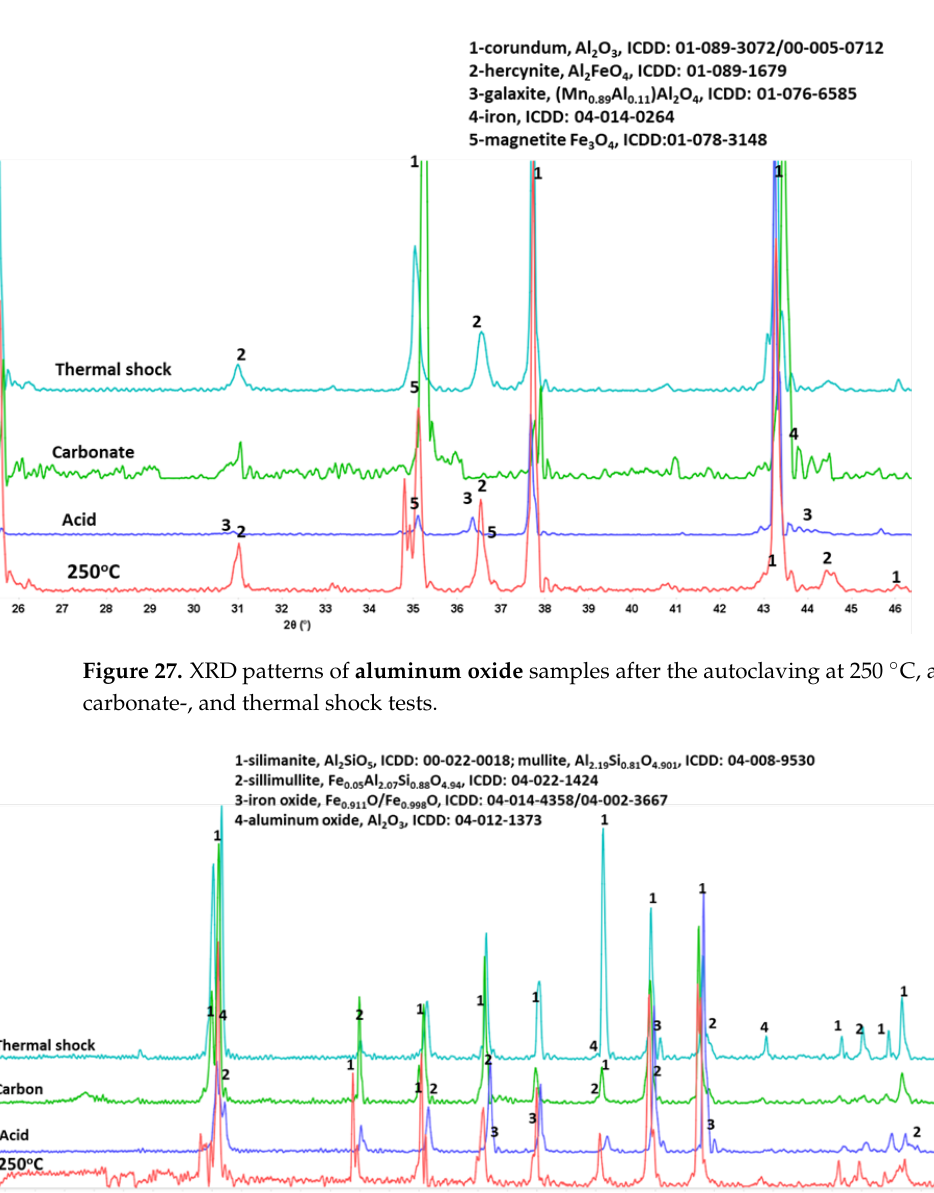
Figure 28. XRD patterns of mullite samples after the autoclaving at 250 °C, acid-, alkaline carbonate-, and thermal shock tests.